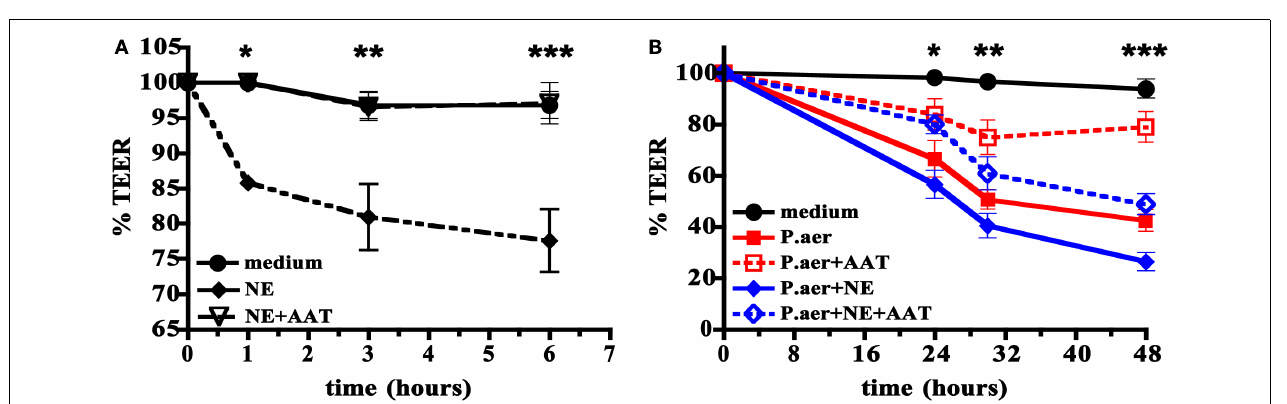
with AAT ( P.aer + AAT, red open squares with dashed line), P.aer and human NE ( P.aer + NE, blue closed diamonds with solid line), or with P.aer and human NE with AAT ( P.aer + NE + AAT, blue open diamonds with dashed line). Data are expressed as percent ofTEER measurements in each condition just prior to addition of P.aer (defined as T = 0 and set to 100%).The means ± SEM are shown for three separate experiments. * For T = 24h, significant differences were noted for medium compared to P.aer ( p < 0.01), medium compared to P.aer + NE ( p < 0.001), and for P.aer compared to P.aer + AAT ( p < 0.05). ** For T = 30h, significant differences were noted for medium compared to P.aer ( p < 0.001), medium compared to P.aer + NE ( p < 0.001), P.aer compared to P.aer + AAT ( p < 0.01), and for P.aer + NE compared to P.aer + NE + AAT ( p < 0.05). *** For T = 48h, significant differences were noted for medium compared to P.aer ( p < 0.001), medium compared to P.aer + NE ( p < 0.001), P.aer compared to P.aer + AAT ( p < 0.001), and for P.aer + NE compared to P.aer + NE + AAT ( p <